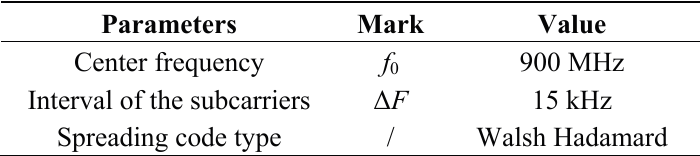
Table 3. The simulation parameters of MC-CDMA.